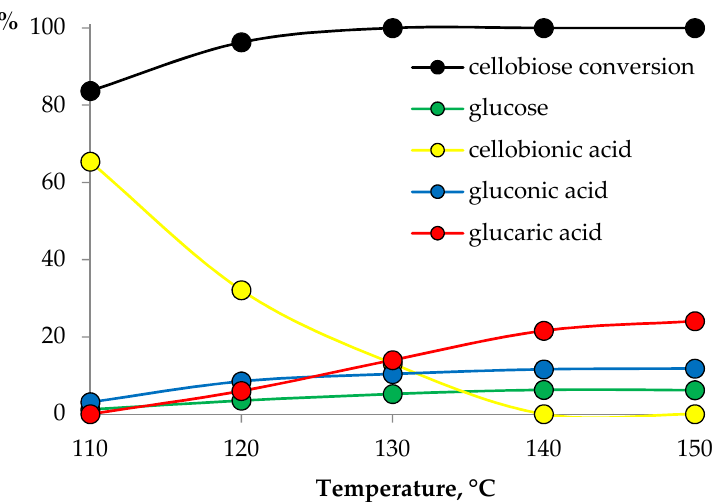
Figure 4. Dependence of cellobiose conversion and yields of main products according to the reaction temperature (cellobiose, 0.5 g; 3% Pt/HPS MN270, 0.1 g; H 2 O, 20 mL; O 2 , 5 bar; 3 h).